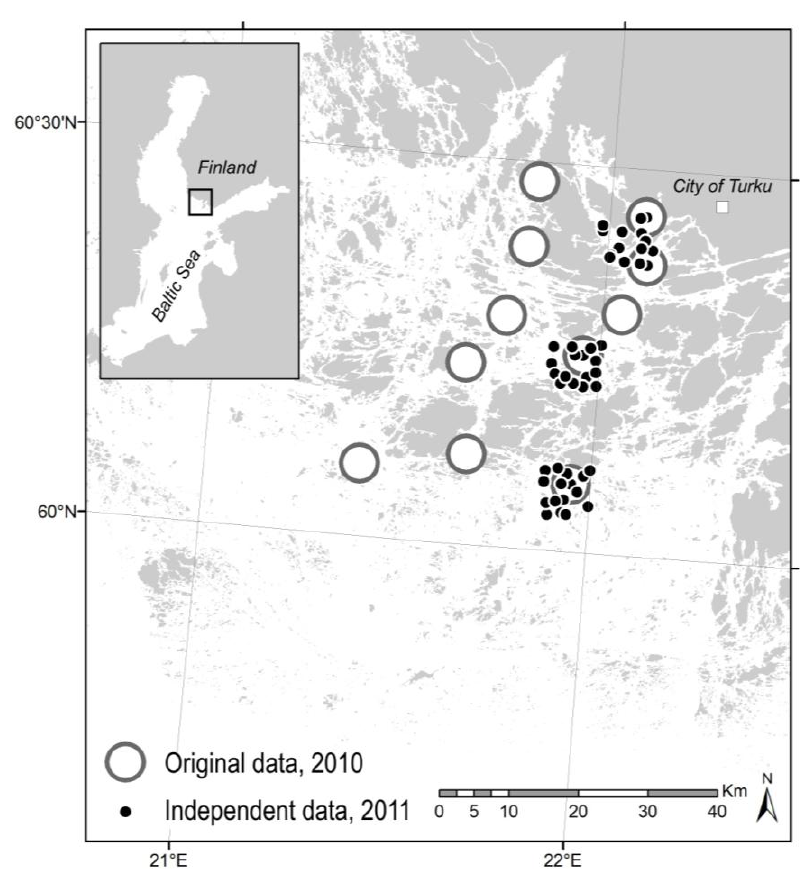
Figure 1. The study area and the sampling